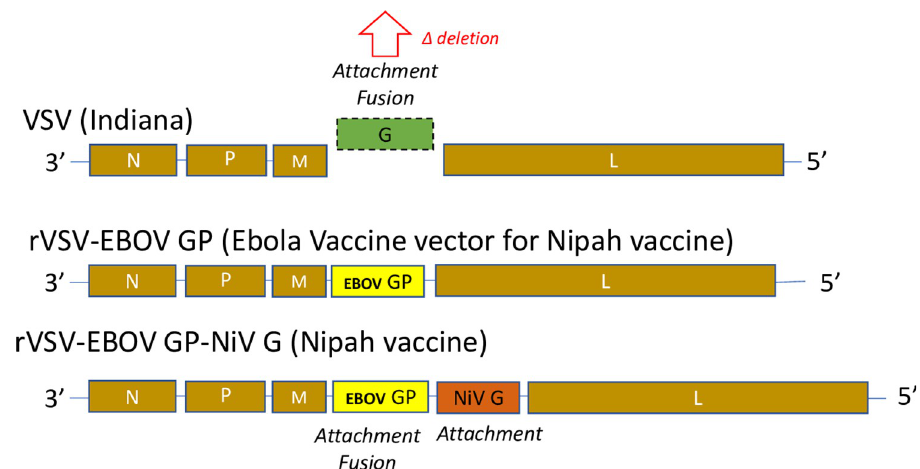
Fig 1. Schematic of genome organization of wild-type VSV (top), rVSV-EBOV (Ebola) vector (center) showing the substitution of the EBOV GP gene for the glycoprotein (G) gene and principal virulence factor of wild-type VSV, and rVSV-Nipah (bottom) showing the addition of NiV G encoding the NiV attachment glycoprotein downstream of the EBOV GP.